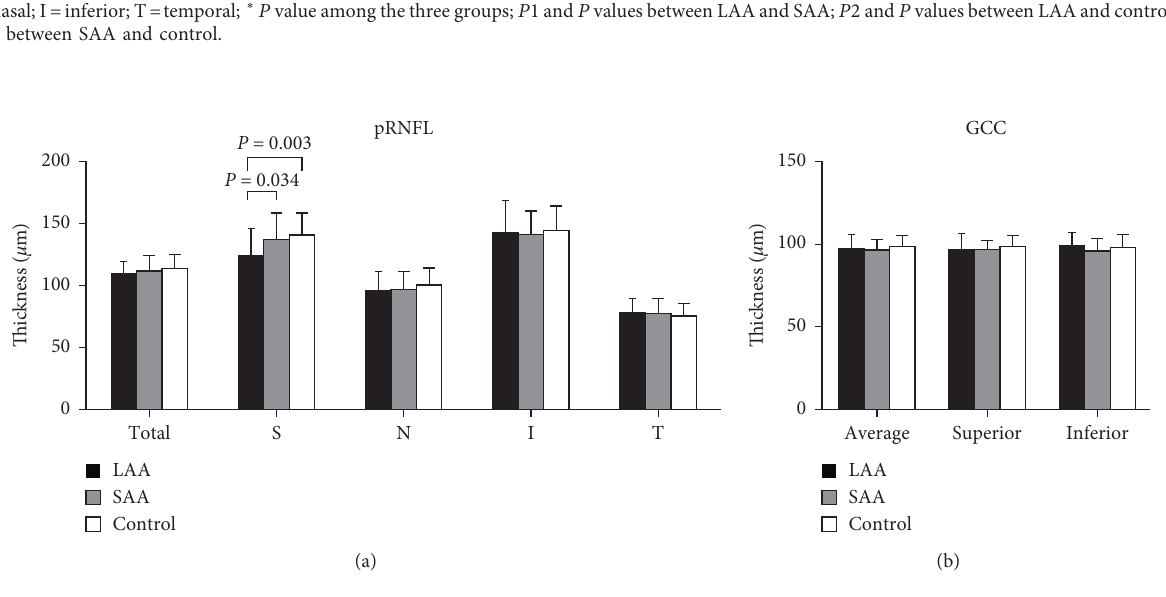
Figure 2: (a) Peripapillary retinal nerve fiber layer (pRNFL) thickness in eyes of patients with large-artery atherosclerosis (LAA), small- vessel occlusion (SAA), and controls. S � superior; N � nasal; I � inferior; T � temporal. (b) Ganglion cell complex (GCC) thickness in three groups. Table 4: Comparison of microvascular density in patients with LAA, SAA, and controls between the superficial and deep retinal capillary plexus.